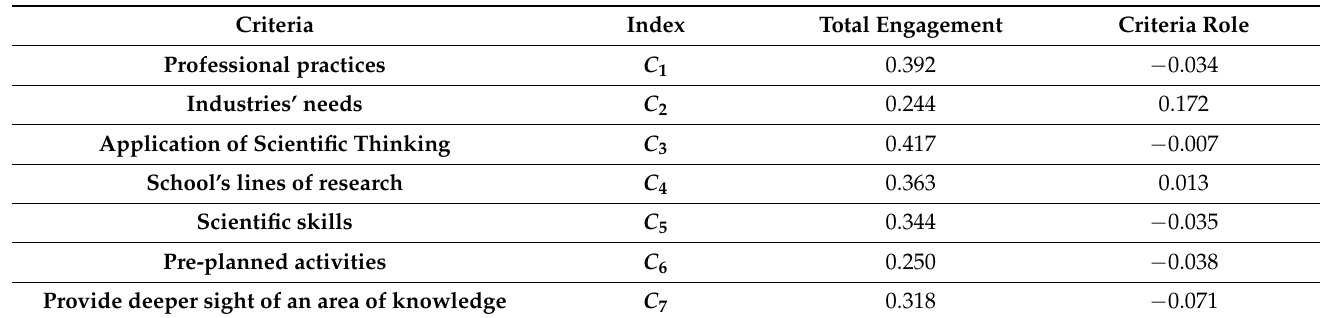
Table 11. Experiment 2